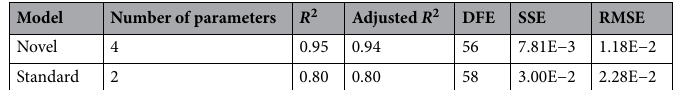
Table 1. Statistical analysis of the fitting with standard and novel